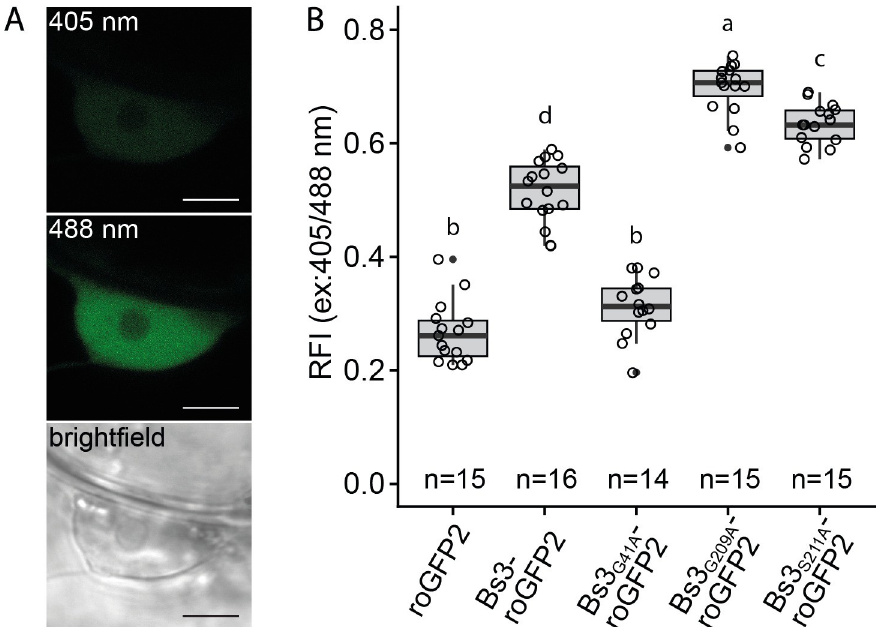
Fig 6. In planta oxidase activity of Bs3 and its derivatives. A) Representative pictures of roGFP2 fluorescence in the nucleus with excitation at 405 and 488 nm. Scale bar = 5 μ m B) RoGFP2 oxidation is increased in Bs3 , Bs3 Bs3 S211A expressing leaf tissue. Indicated constructs were expressed under control of the 35S promoter in N . benthamiana via Agrobacterium -mediated transient transformation. 30 hpi leaf discs were analysed by ratiometric laser scanning microscopy and the ratios of fluorescence intensity (RFI) upon excitation at 405 and 488 nm was determined. n = number of observations. Single values are depicted as black circles. Different letters denote statistically significant differences (P < 0.05, ANOVA with posthoc Tukey Honest Significant Difference